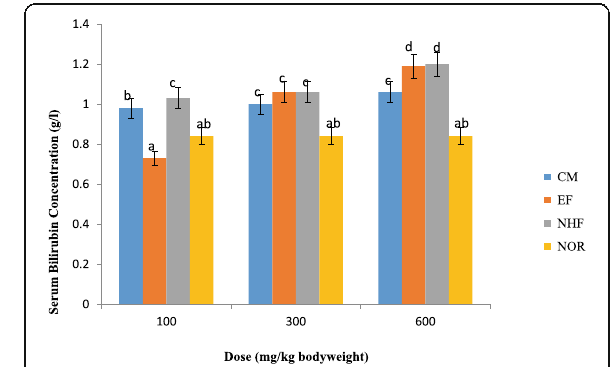
Fig. 4 Effect of crude extract and fractions of Gymnema sylvestre on serum bilirubin concentrations of rats. Mean with different superscripts differ significantly (p < 0.05). Key: NOR: normal control, CM: crude methanol extract, EF: ethyl acetate fraction,